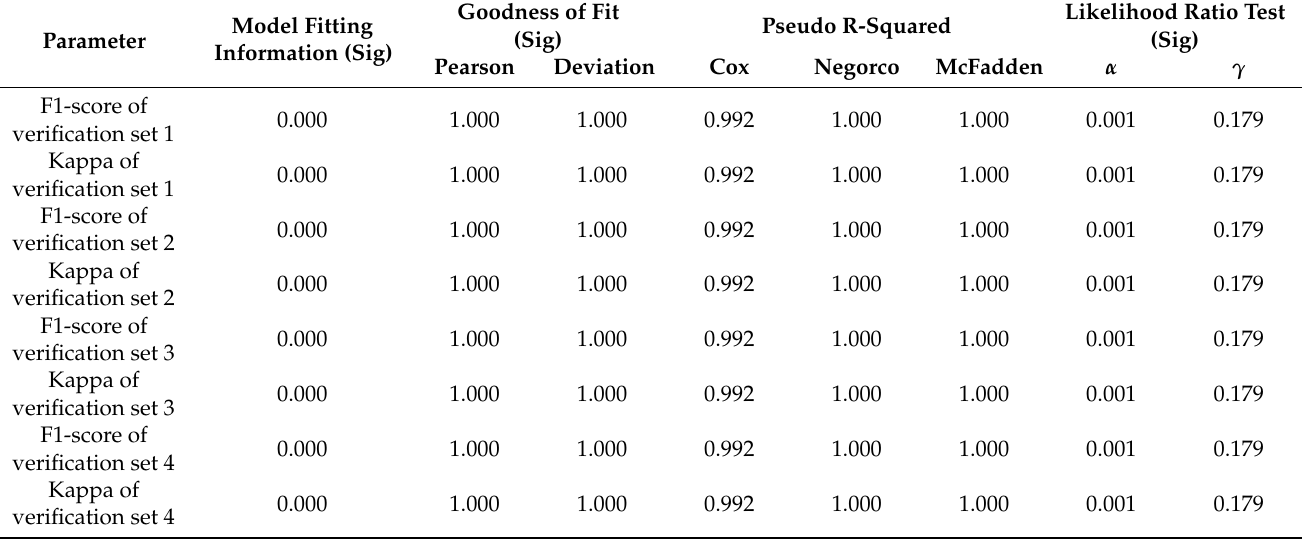
Table 5. Multivariate logistic regression analysis of two parameters and their accuracy on the four verification sets.